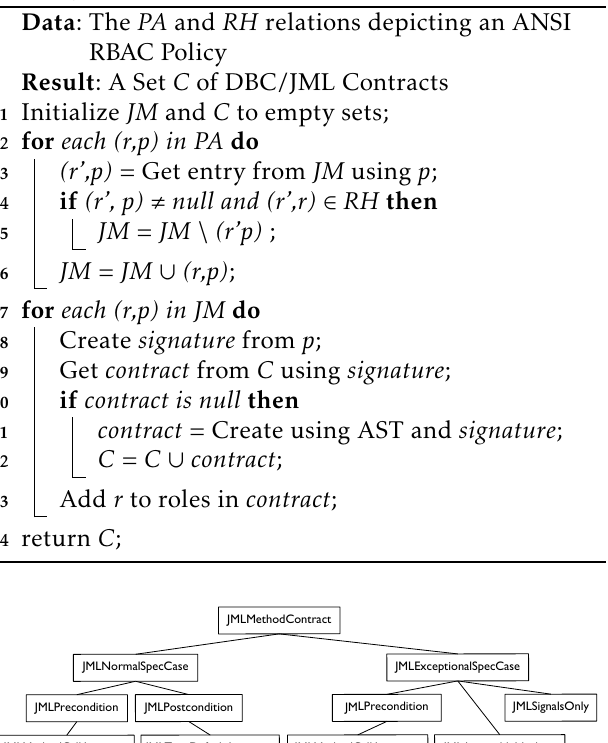
Table 1. Distribution of Responsibilities for Enforcing an Assertion-basedSecurity ModelIn a Collaborative